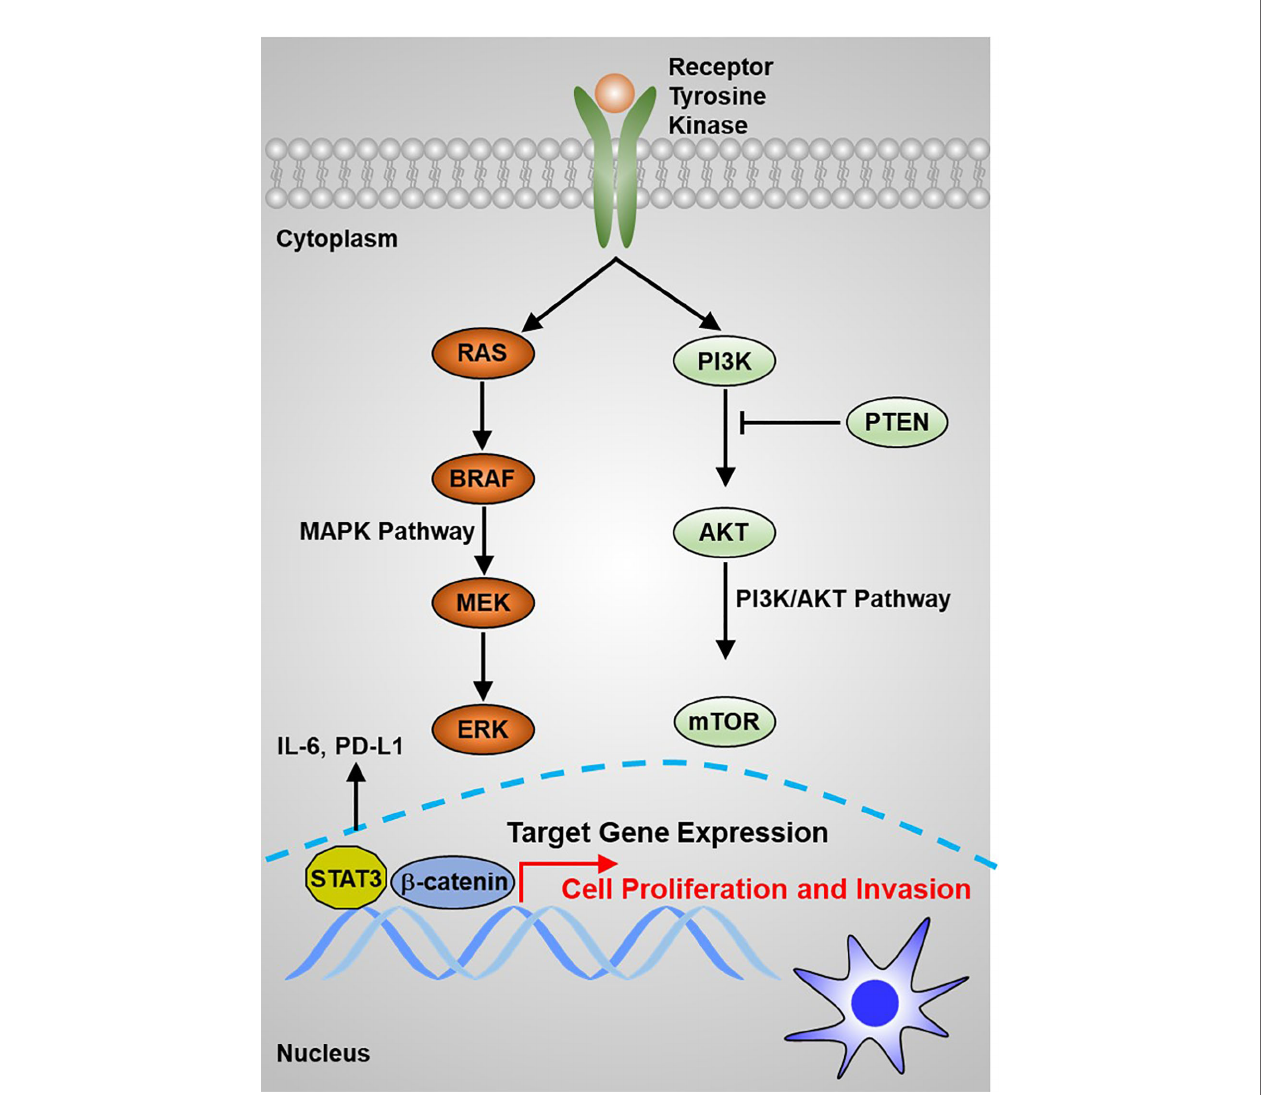
FIGURE 2 | The main signaling pathways that contribute to thyroid carcinoma tumorigenesis are the MAPK and PI3K/AKT